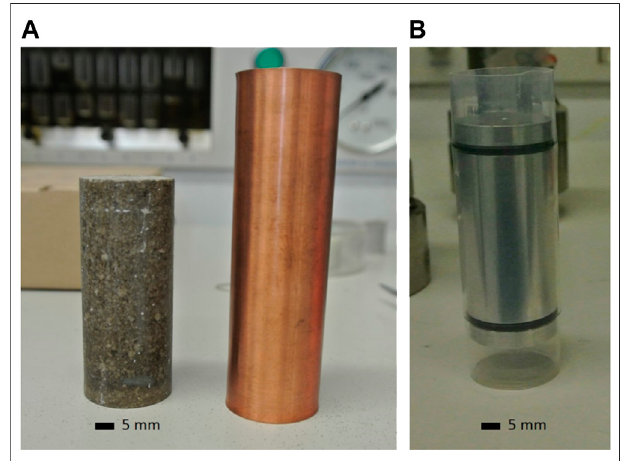
FIGURE 5 | Jacketing (A) Copper jacket, used for the carbonate (B) Shrink tube, used for the aluminum standard.